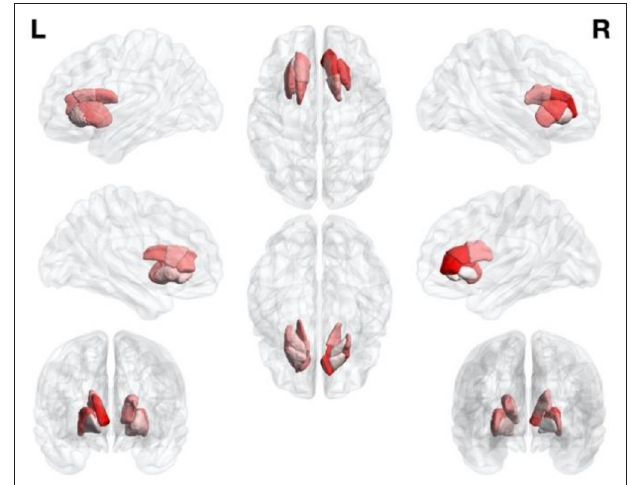
FIGURE 3 | Relative contribution of different components of the striatum to the proposed computer-aided classification framework. Intensity of colors reflects the magnitude of